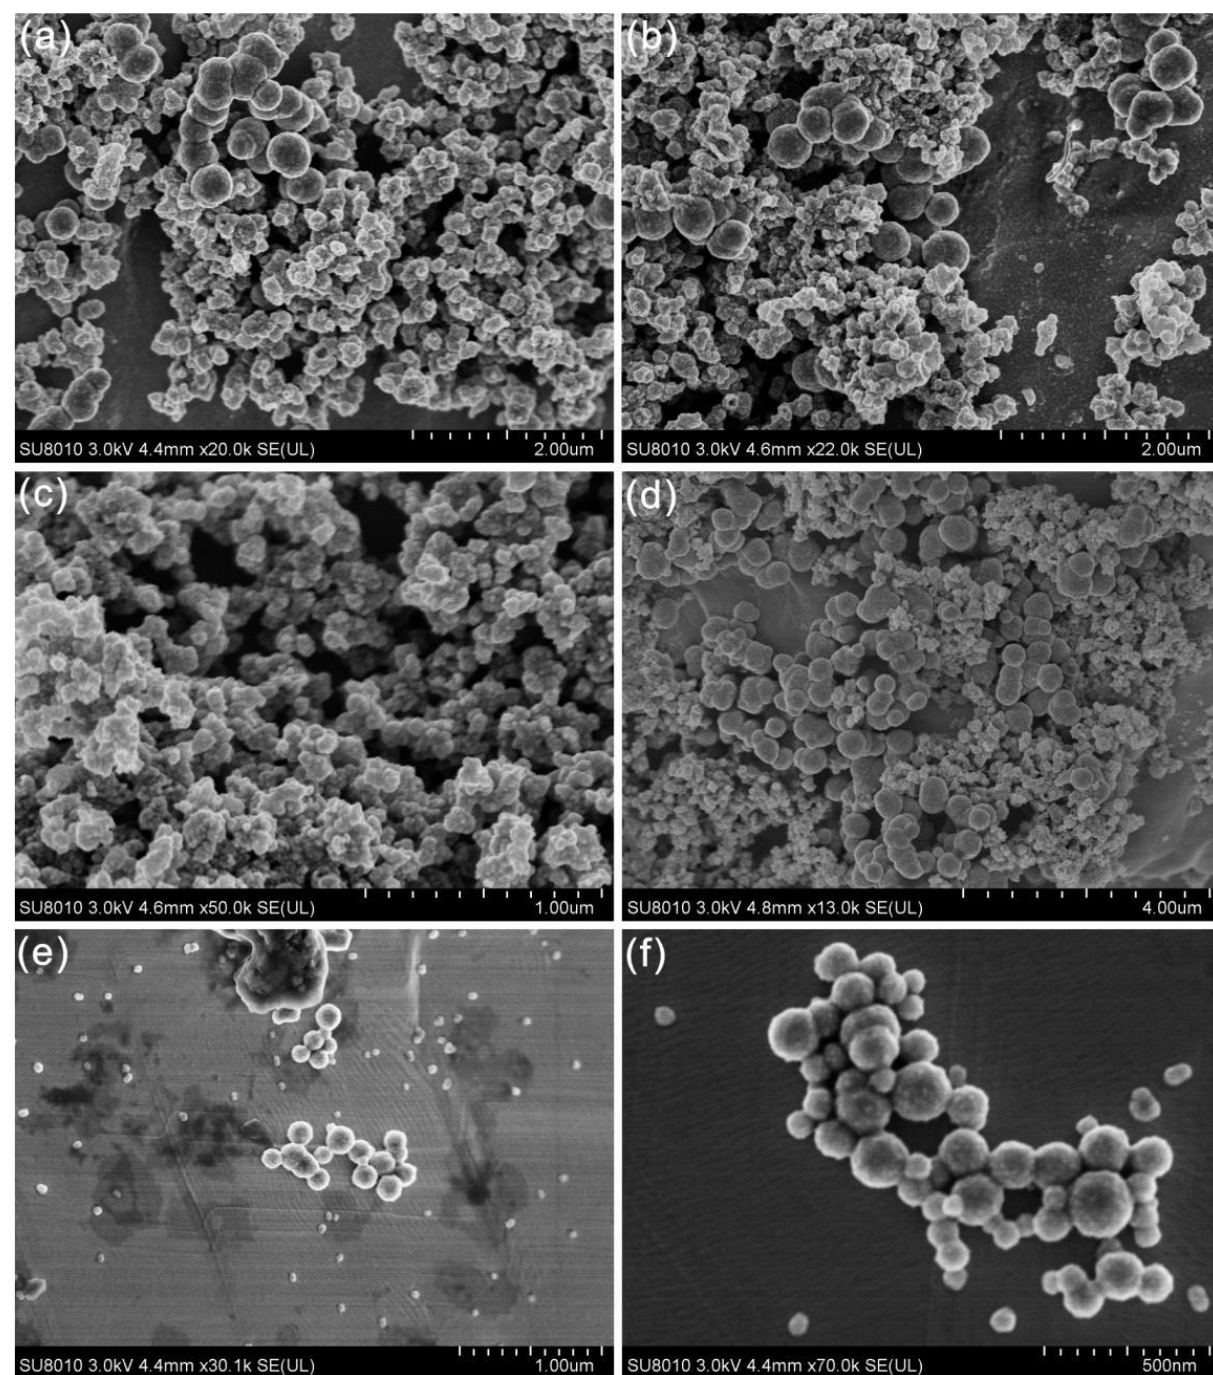
Figure 5. Representative SEM micrographs of OsO 2 nanospheres using 0.005 mol/L initial solution for: ( a ) No. 7 at 150 °C, 100 MPa, and 24 h; ( b ) No. 8 at 250 °C, 100 MPa, and 24 h; ( c ) No. 9 at 350 °C, for: ( a ) No. 7 at 150 ◦ C, 100 MPa, and 24 h; ( b ) No. 8 at 250 ◦ C, 100 MPa, and 24 h; ( c ) No. 9 at 350 ◦ C, 100 MPa, and 24 h; ( d ) No. 10 at 450 °C, 100 MPa, and 24 h; and ( e , f ) No. 11 at 550 °C, 100 MPa, and 100 MPa, and 24 h; ( d ) No. 10 at 450 ◦ C, 100 MPa, and 24 h; and ( e , f ) No. 11 at 550 ◦ C, 100 MPa, and 24 h. 24